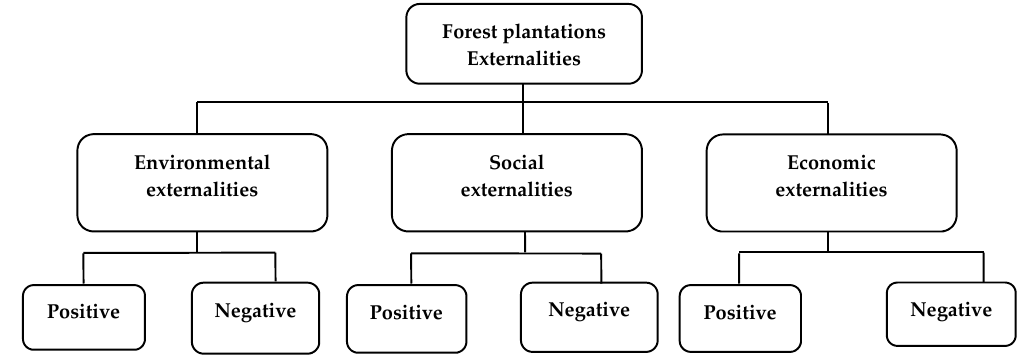
Figure 4. Hierarchical structure of the AHP method adapted for the study.